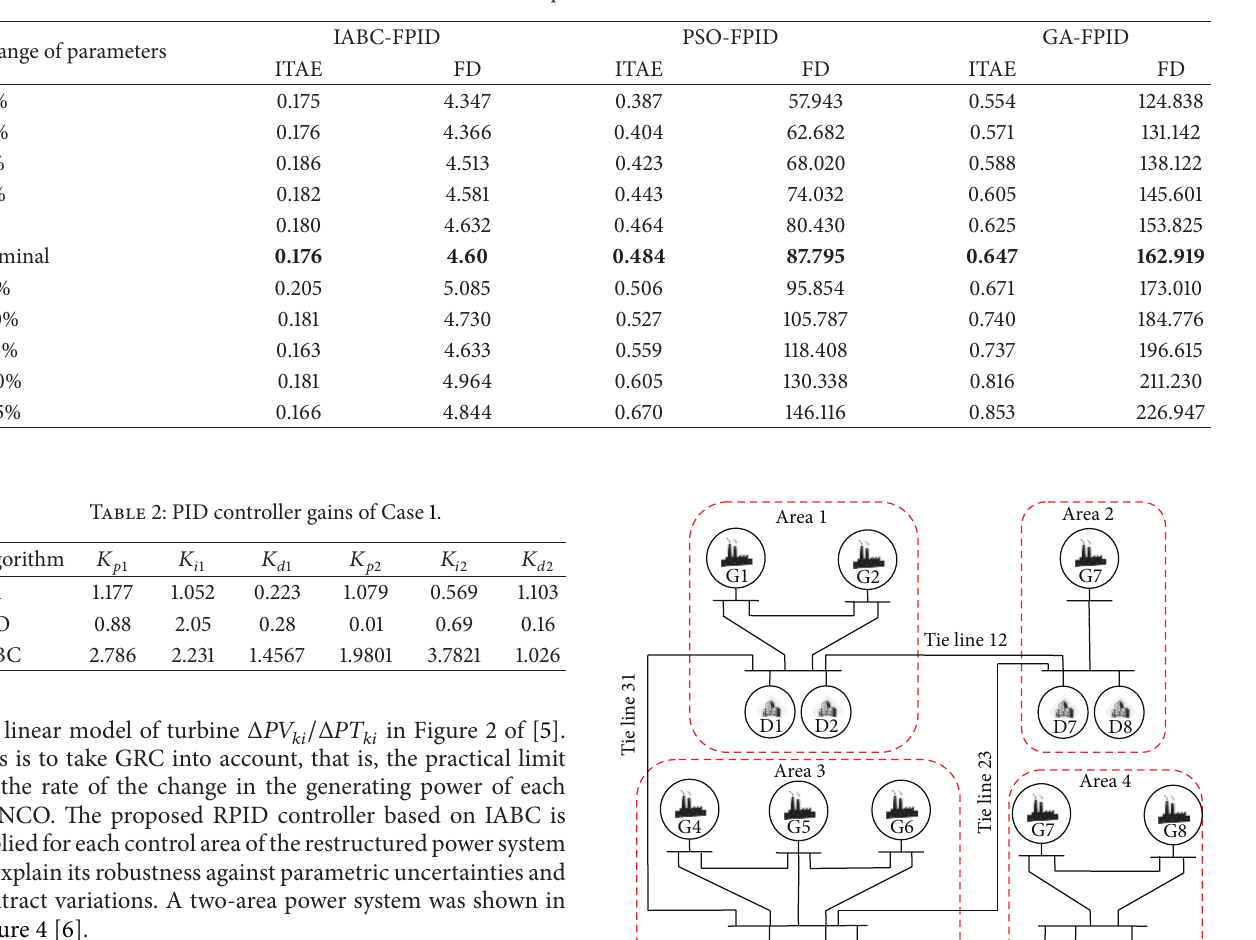
Table 1: ITAE and FD performance indices for Case 1.